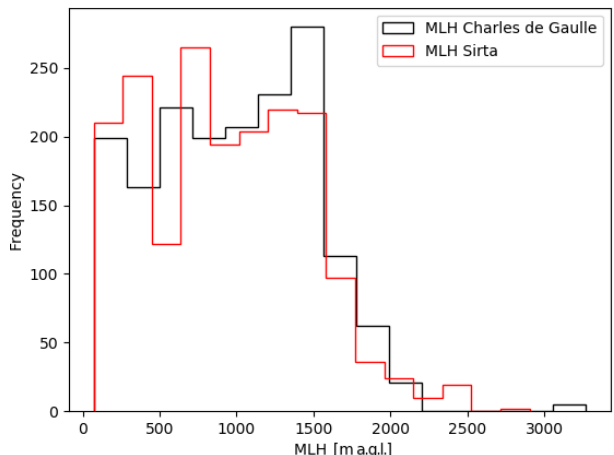
Figure A2. Histogram showing the frequency of occurrence for MLH [ma.g.l.] measured at SIRTA (red) vs. MLH measured at Charles de Gaulle airport